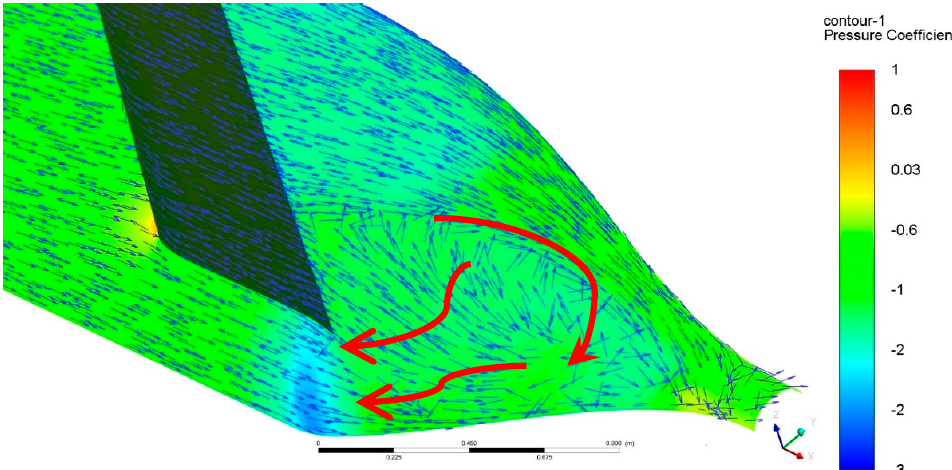
Figure 9. Aft–wing–body flow field visualization and direction of reverse flow on the aft body.